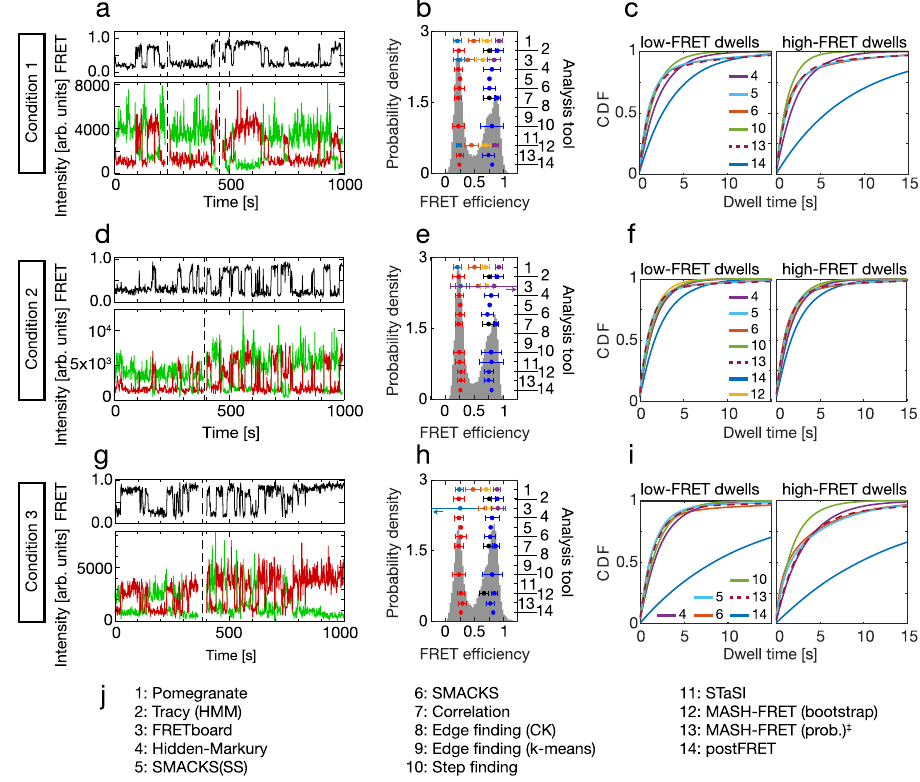
Fig. 5 | Increased experimental complexity. Results inferred from three experi- mental datasets where naturally no GT exists. a , d , g Experimental traces, offset in time and separatedby dashedverticallines, withdonor and acceptor fl uorescence intensity (green, red) and FRET ef fi ciency (FRET, black), representative for the datasets used in ( b , c ), ( e , f ), ( h , i ), respectively, with n(traces): 134, 163, 118; and n(datapoints): 36,604, 37,067, 43,512; sampling rate=33Hz, time per datapoint= 30ms.AllthreedatasetswerekindlyprovidedbyM.Schlierf. b , e , h FRETef fi ciency histograms and FRET ef fi ciencies inferred by the analysis tools numbered as in ( j